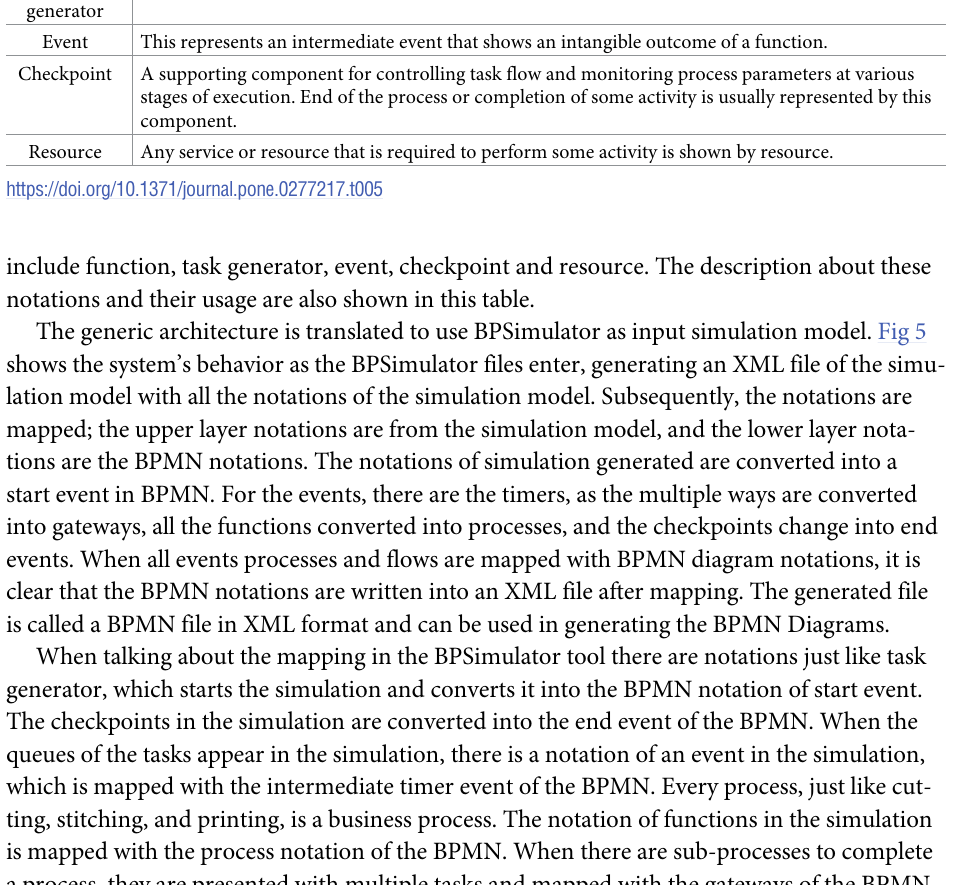
Table 5. BPSimulator notations with description. As name indicates, it is used to represent the action that occurs during the process. It is the start point for the process. Tasks are starting from this point in the process. Event This represents an intermediate event that shows an intangible outcome of a function. Checkpoint A supporting component for controlling task flow and monitoring process parameters at various stages of execution. End of the process or completion of some activity is usually represented by this component. Any service or resource that is required to perform some activity is shown by resource.